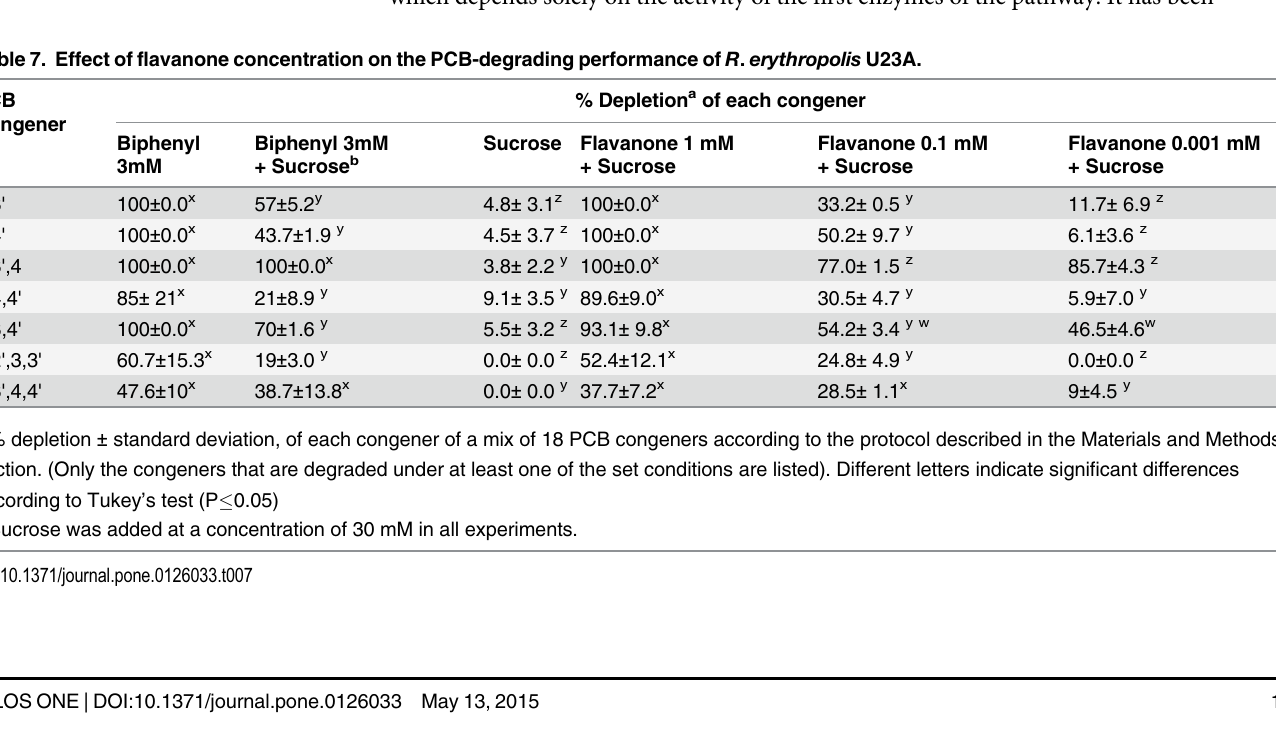
% Depletion a of each congener Sucrose Flavanone 1 mM + Sucrose